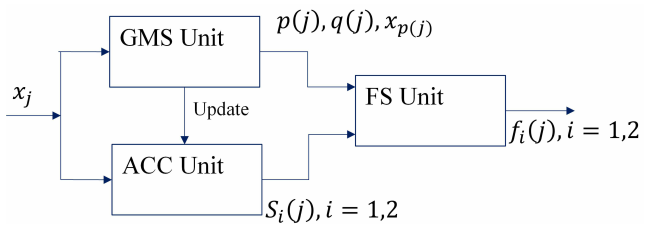
Figure 5. The proposed architecture for feature